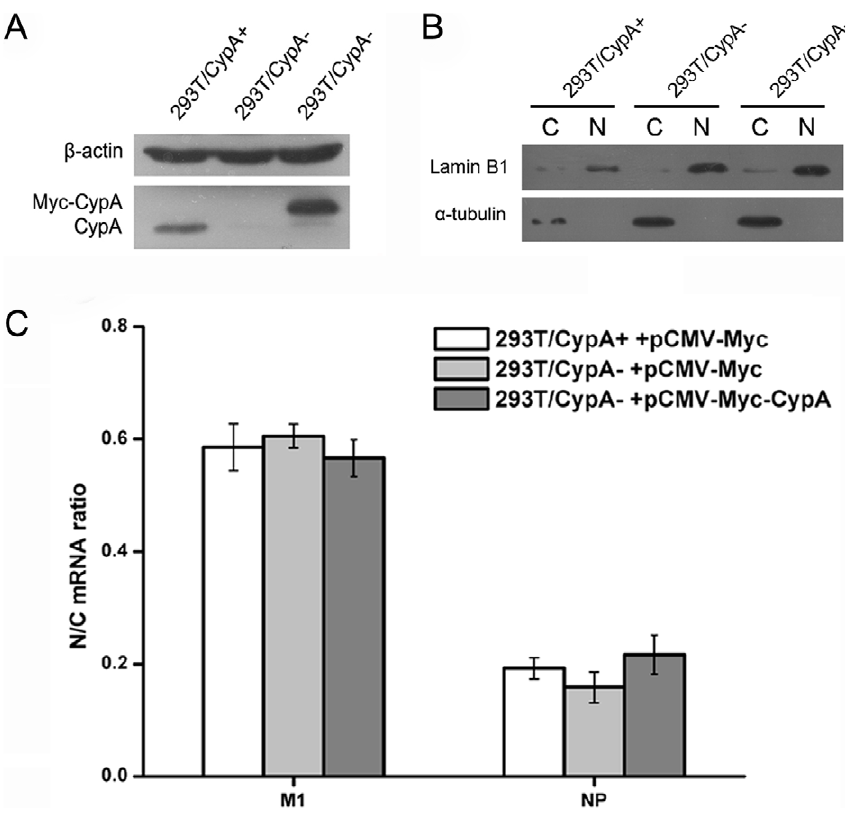
Figure 4. CypA did not impair the nuclear export of influenza virus mRNA. The 293T/CypA + , 293T/CypA 2 , and CypA re-expression 293T/ CypA 2 cell lines were infected with A/WSN/33 (MOI=0.1). At 4 h post-infection, the CypA expression level was analyzed by western blotting using a polyclonal anti-CypA antibody in the three cell lines. b -actin was used as a control (A). Nuclear (N) and cytoplasmic (C) components were isolated from the various cell lines. One tenth of the components were used for Western blot by anti- a -tubulin and anti-lamin B1 (B). The rest of the components were used for the RNA extraction and real time PCR (C). M1 and NP mRNA levels were quantified by real-time RT-PCR using gene-specific primers. GAPDH was quantified as an internal control. Data are means 6 SD of three separate experiments.